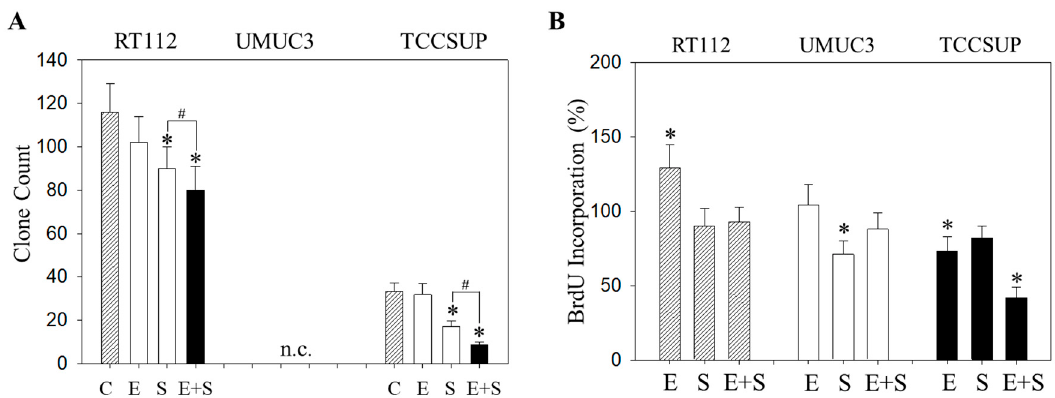
Figure 7. Evaluation of clonogenic growth ( A ) and BrdU incorporation ( B ) under the long-term application of 0.5 nM everolimus (E) or 2.5 µ M sulforaphane (S) or 0.5 nM everolimus + 2.5 µ M sulforaphane (E + S). Control cells (C) remained untreated. RT112 clones were counted at day 8 and TCCSUP at day 10 following incubation. UMUC3 cells did not form clones (n.c.- not counted). The BrdU assay was carried out with synchronized cells with untreated control cells set at 100%. * indicates significant di ff erence to untreated controls. # indicates significant di ff erence between the monotherapy and the combination